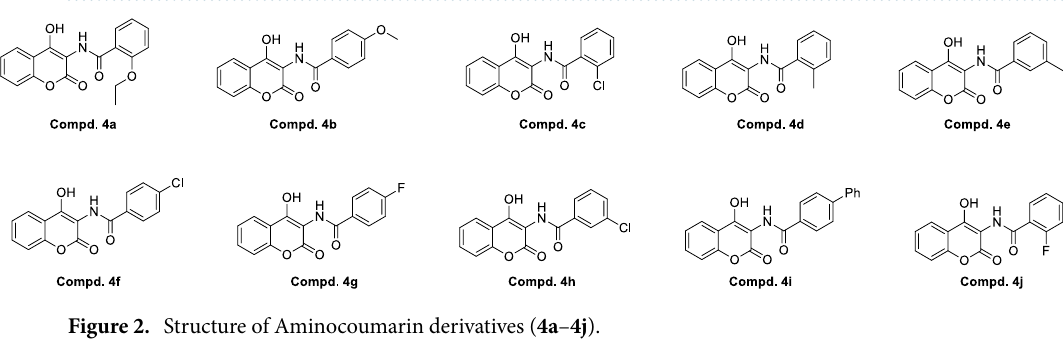
Figure 1. Synthesis pathway of coumarin analogues. Reagents and conditions: ( a ) HNO 3 , NaNO 2 , AcOH, 1 h, 60 °C; ( b ) H 2 , Pd/C, EtOH, 8 h, rt; ( c ) Benzoyl chloride, Pyridine, CH 2 Cl 2 , 8 h, rt.